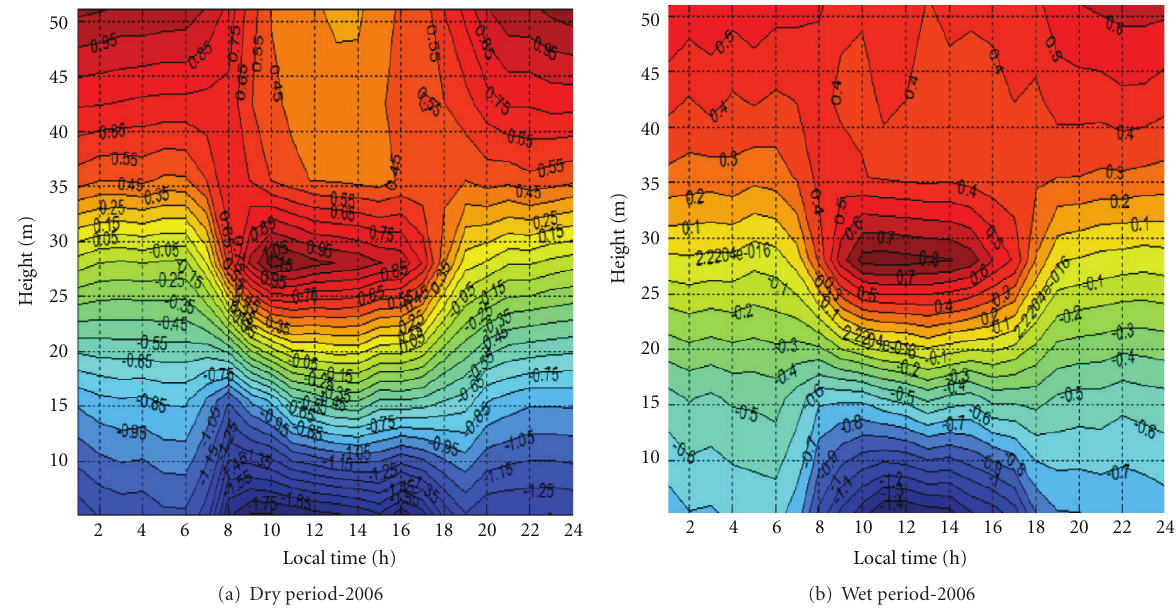
Figure 7: Daily course of the vertical deviation of the virtual potential temperature ([ θ (cid:3) v = θ v ( z ) − θ v ( z ) 55 periods of 2006, over plateau K34 tower.